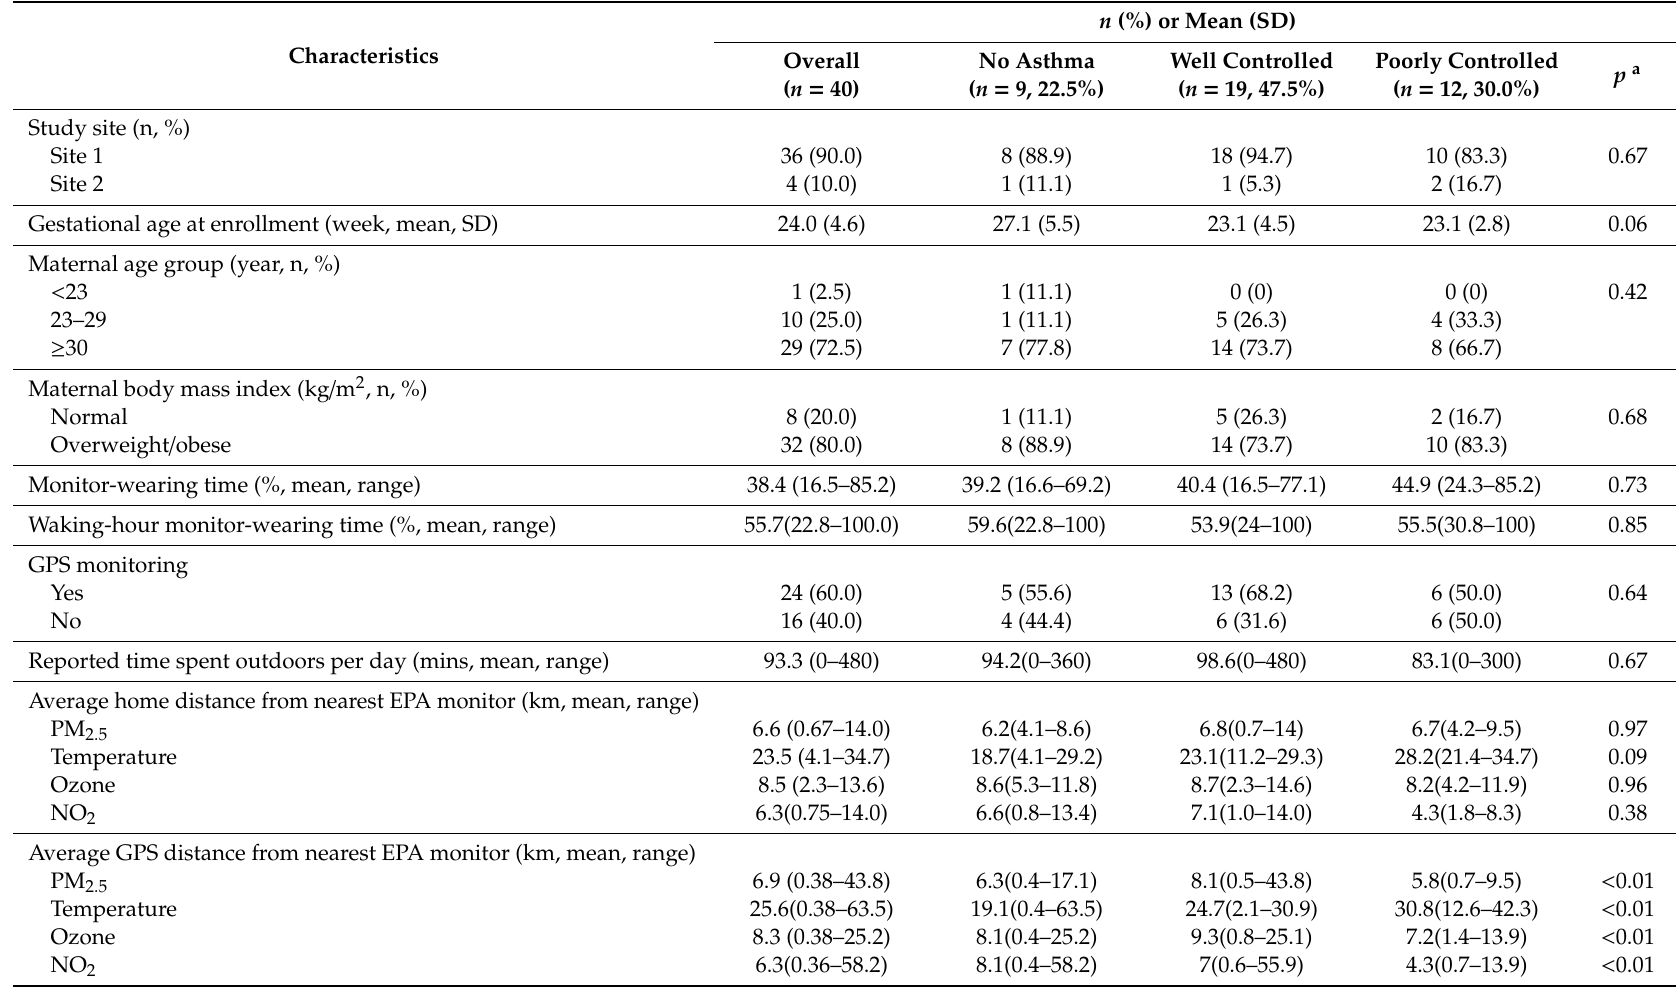
Table 1. Characteristics of B-WELL-MOM participants who participated in the air-monitoring sub-study ( n =